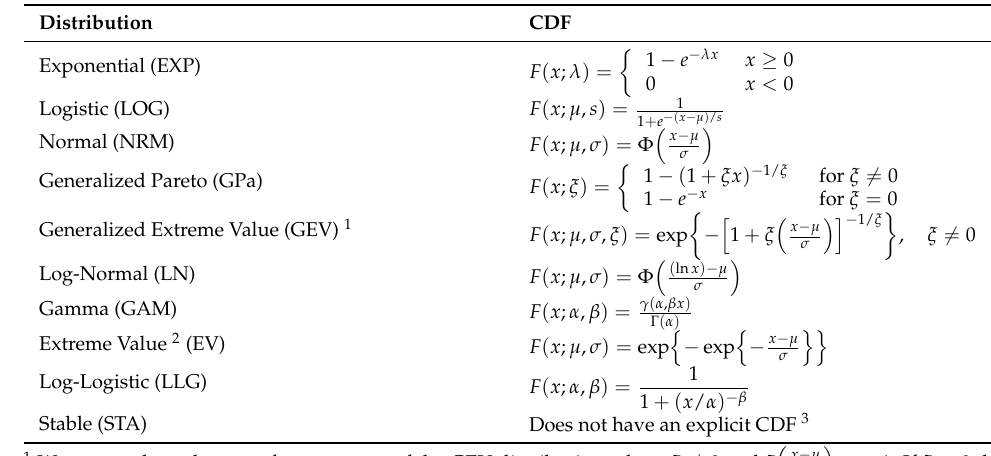
Table 2. Theoretical distributions used in the fog events duration analysis carried out. The non- negative variable x refers to the duration of fog